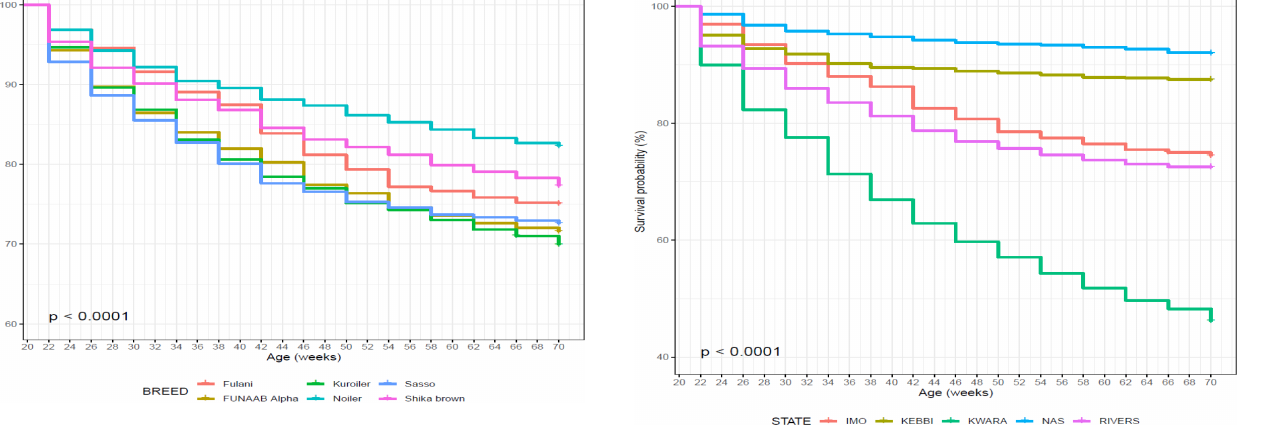
Figure 11. Effect of agroecology on cumulative hazard of female birds raised on-farm in ACGG Nigeria project zones (20–72 weeks)